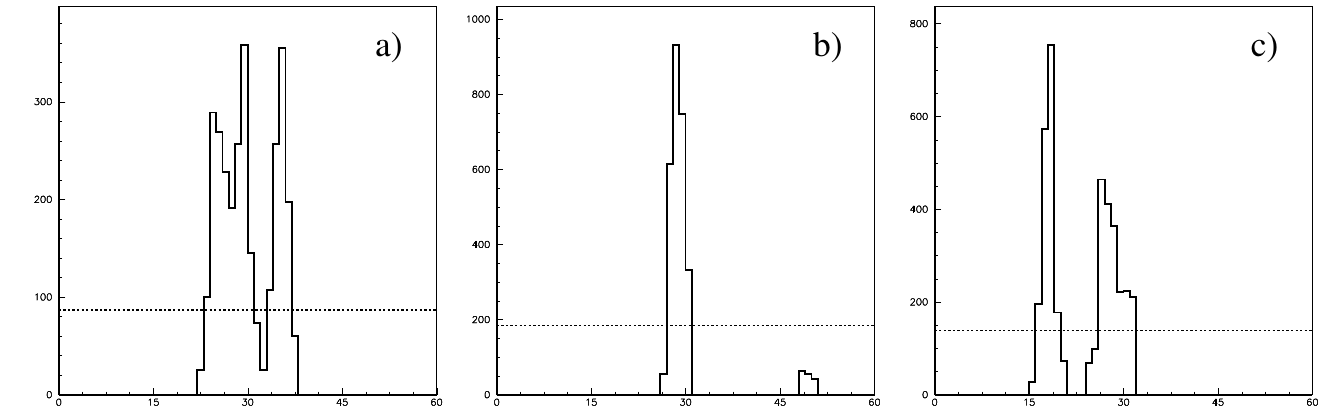
Figure 2. Projections of the pixel signal along the main track axis for the events shown in Figure 1 on ( a – c ) plots, respectively. Abscissa is the position along the track axis (in px) and units on the ordinate shows the sum of brightness of the projected pixels (from 0 to 255 for empty and saturated pixel, respectively). The horizontal dashed lines are the values of the cuts used to determine the length of the track (see text for